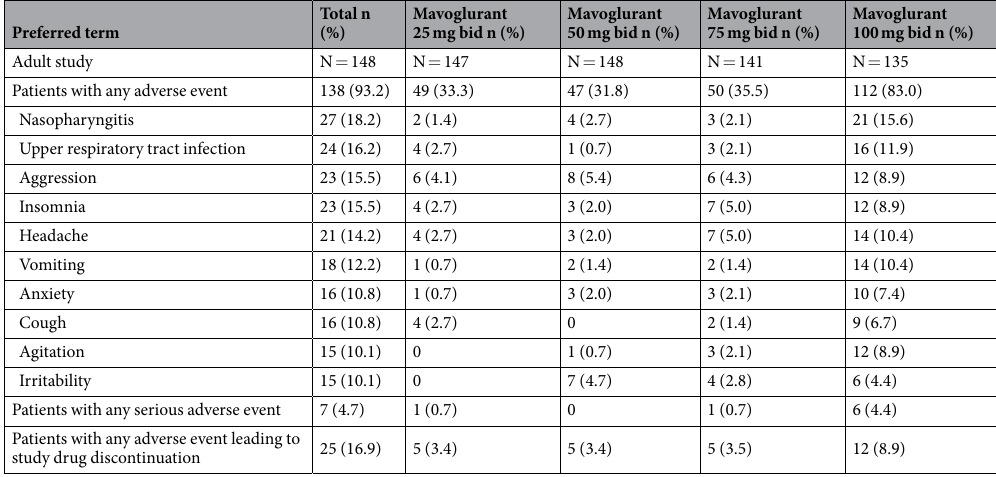
Table 3. Most frequent adverse events * in adult patients during the extension period, by last dose on, or before, event onset (safety population). * Incidence ≥ 10% in any